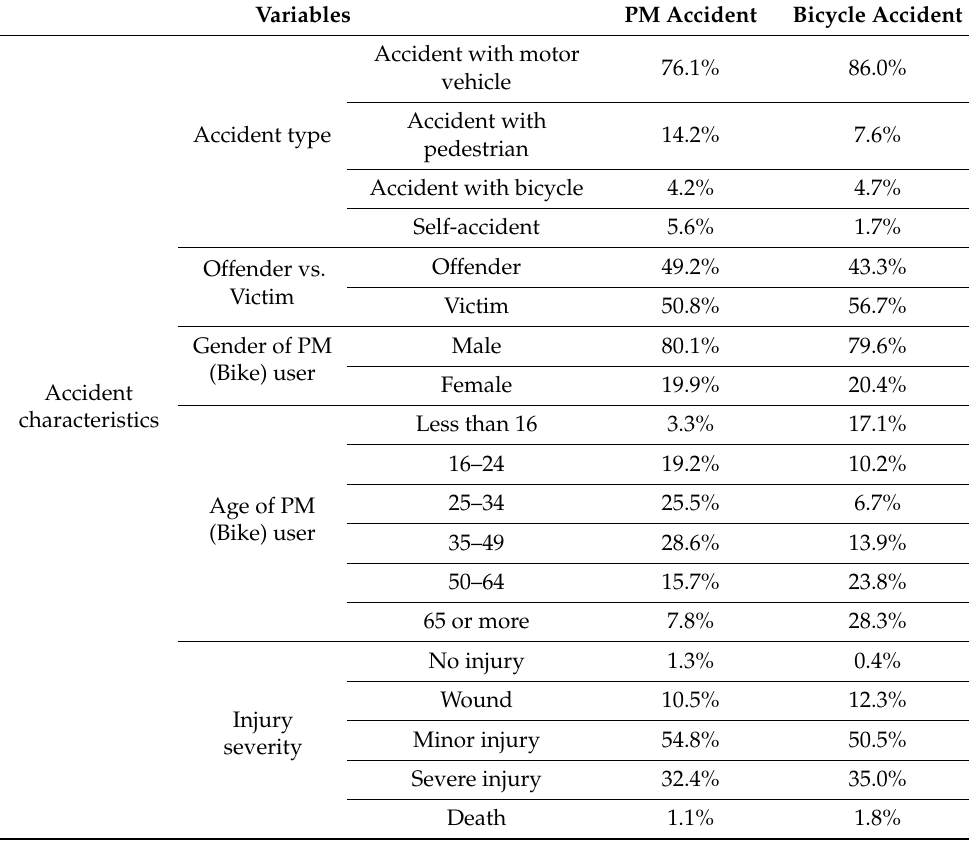
Table 4. Characteristics of PM- and bicycle-related